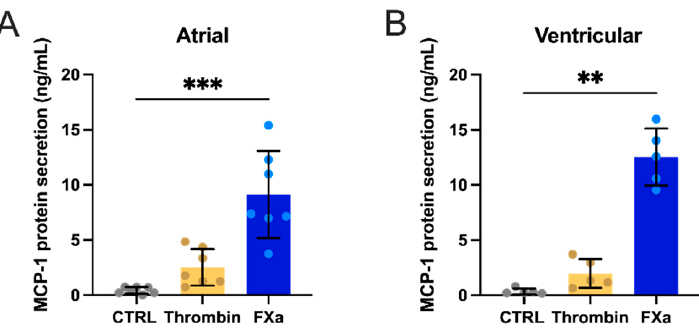
Figure 2. Effect of thrombin and FXa on MCP-1 protein secretion at 24 h in atrial CFs, n = 7 ( A ), and ventricular CFs, n = 5 ( B ). Statistical analysis was performed using the non-parametric Friedman test for paired samples (atrial: overall p < 0.0001; ventricular: overall p < 0.0001) and Dunn’s multiple comparison test (** p < 0.01, *** p < 0.001). Results are expressed as means ± SD.